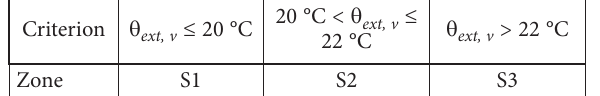
Table 1. Thermal transmission coefficient and solar glass factor of the